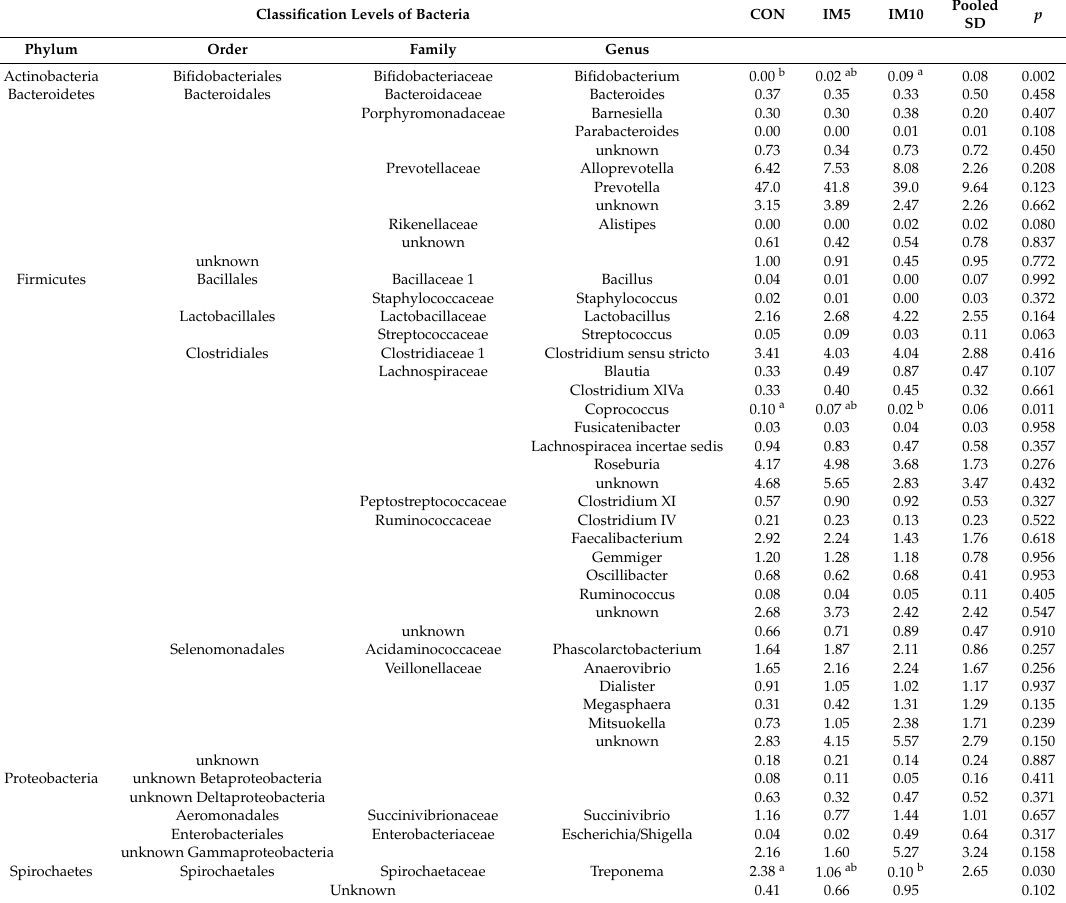
Table 3. Bacterial population composition (genus level) in the cecal digesta of pigs fed isonitrogenous diets without (CON) or with 5% (IM5) or 10% Tenebrio molitor larvae meal (IM10) for four weeks.